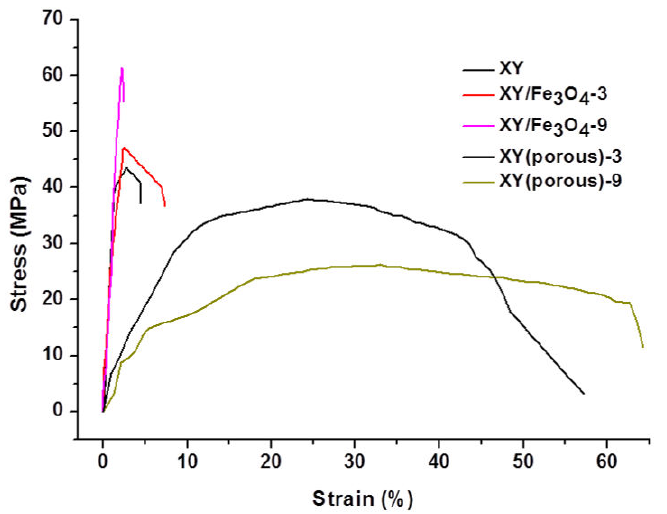
Figure 9. Stress–strain curves of the bare XY, composite, and porous